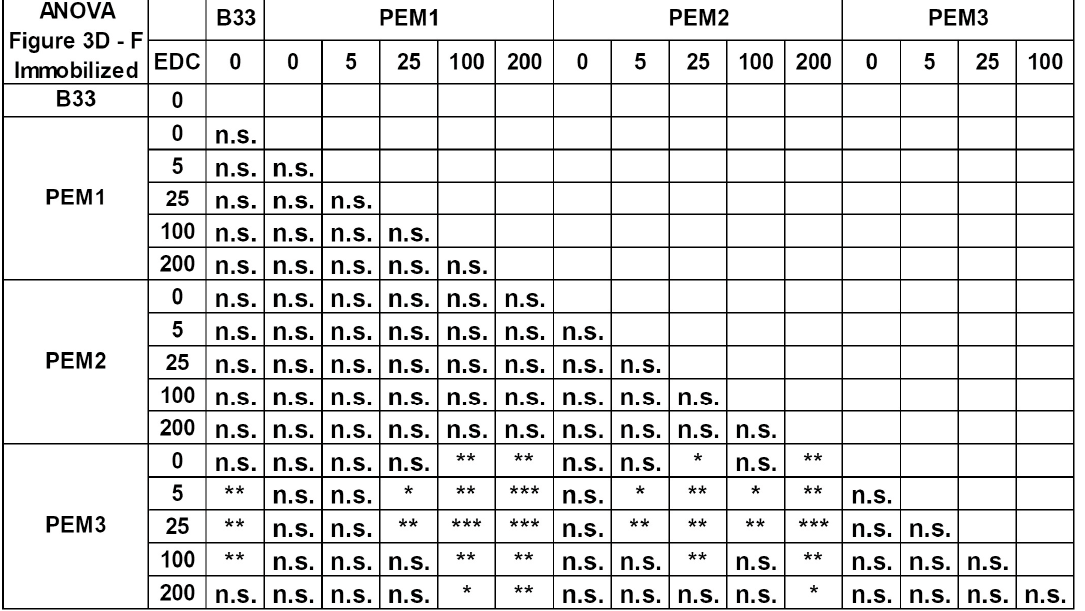
Figure A2. Results of one-way ANOVA for data related to Figure 3D–F; n.s.: not significant; *: p < 0.1; **: p < 0.05; ***: p < 0.001.